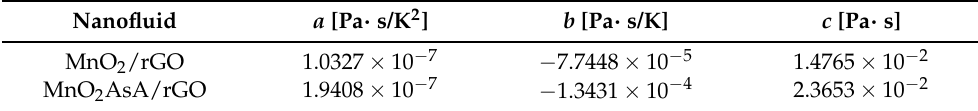
Table 3. Fitted model parameters for the viscosity of the nanofluids prepared with MnO 2